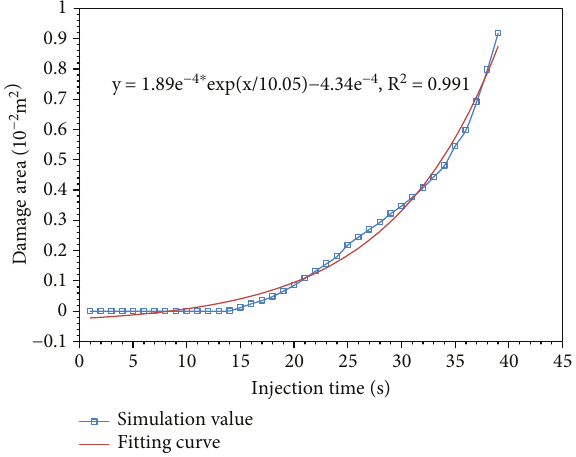
Figure 9: Development of the seepage area versus injection time in the layered jointed sample.